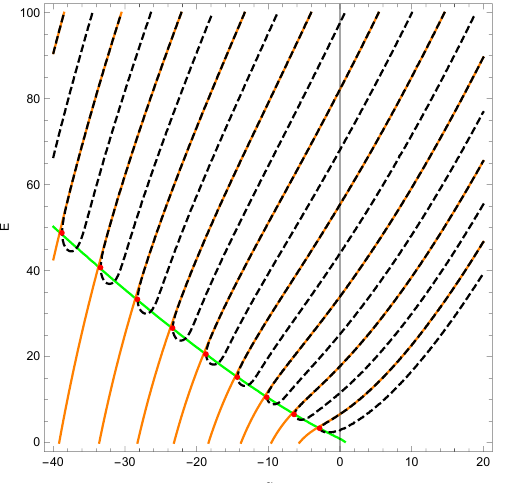
Figure 5 . The black dashed line represents the solution of the spectrum, for ~ = 1. The red dots are the branch points. The green and orange lines are the curves (3.49) and